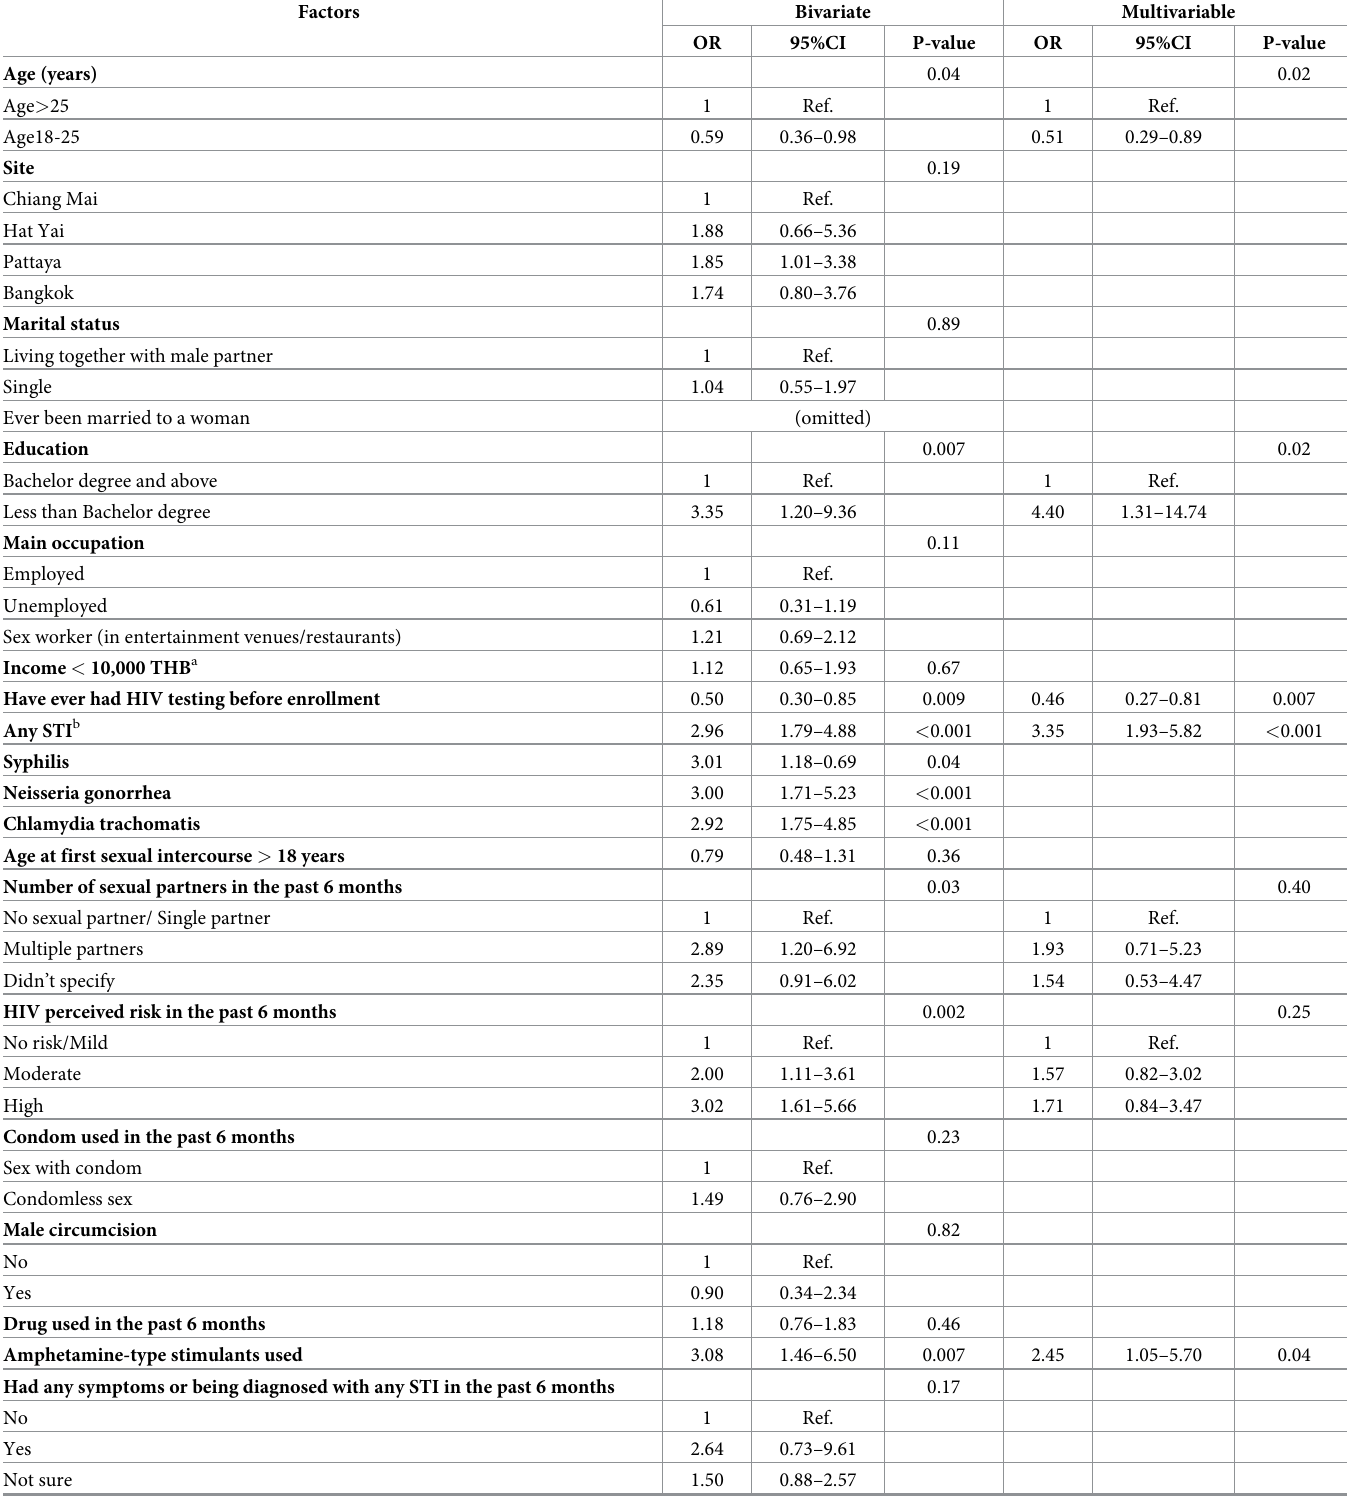
Table 4. Logistic regression of factors associated with HIV prevalence for TGW (N =